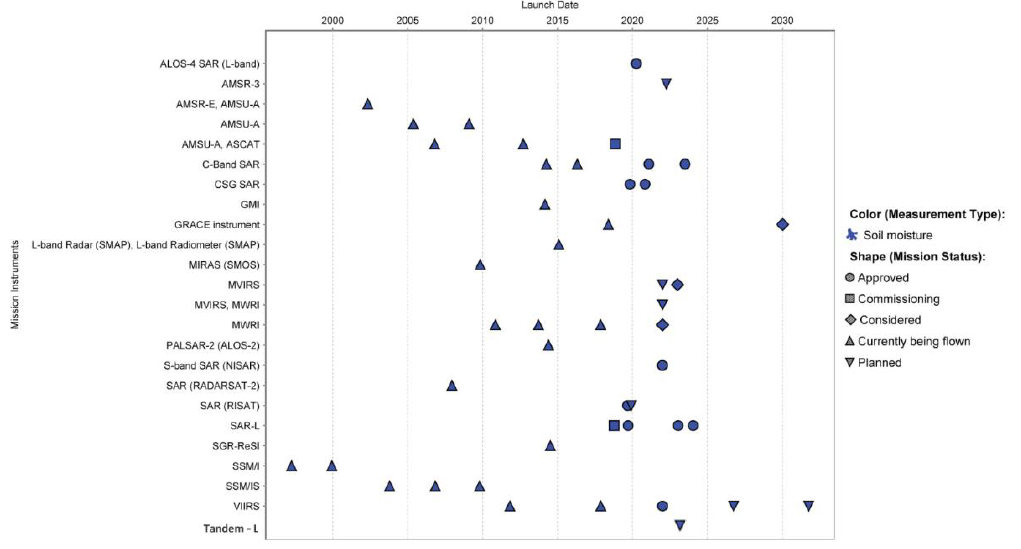
Figure 10. Current and future RS missions instruments for monitoring soil moisture with information about the mission status, extracted from the CEOS database [205]. A selection of RS-aided data products for deriving soil moisture by RS is shown in Table 6. Table 6. Selection of RS-aided data products of soil moisture estimation with RS.